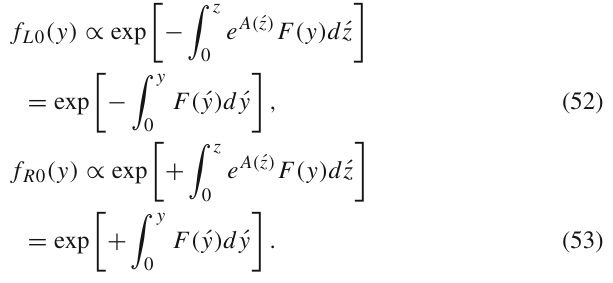
Fig. 6 The profile of a the effective potential and b the graviton zero mode for f ( T ) = T + 1 line), α 1 = − 0 . 01 (dotted